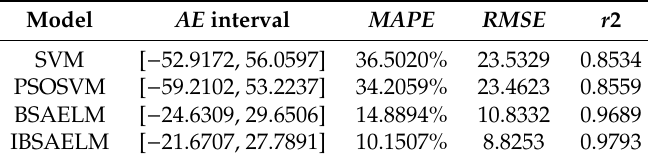
Figure. 5 AE error curves for each model. Figure 5. AE error curves for each model. Table 3. Assessment results for one-day tra ffi c flow Table 3. Assessment results for one-day traffic flow forecasting.